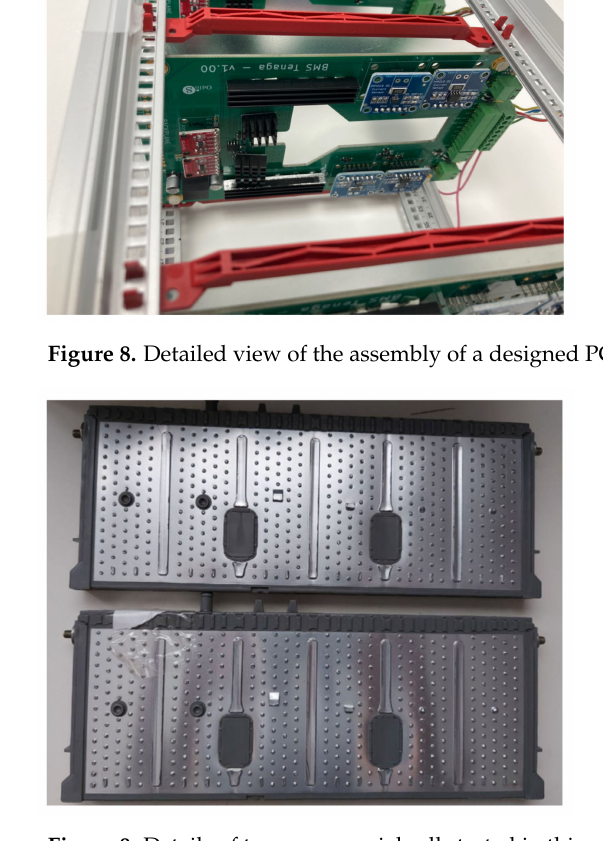
Figure 9. Details of two commercial cells tested in this case study: Toyota Prius battery cells.